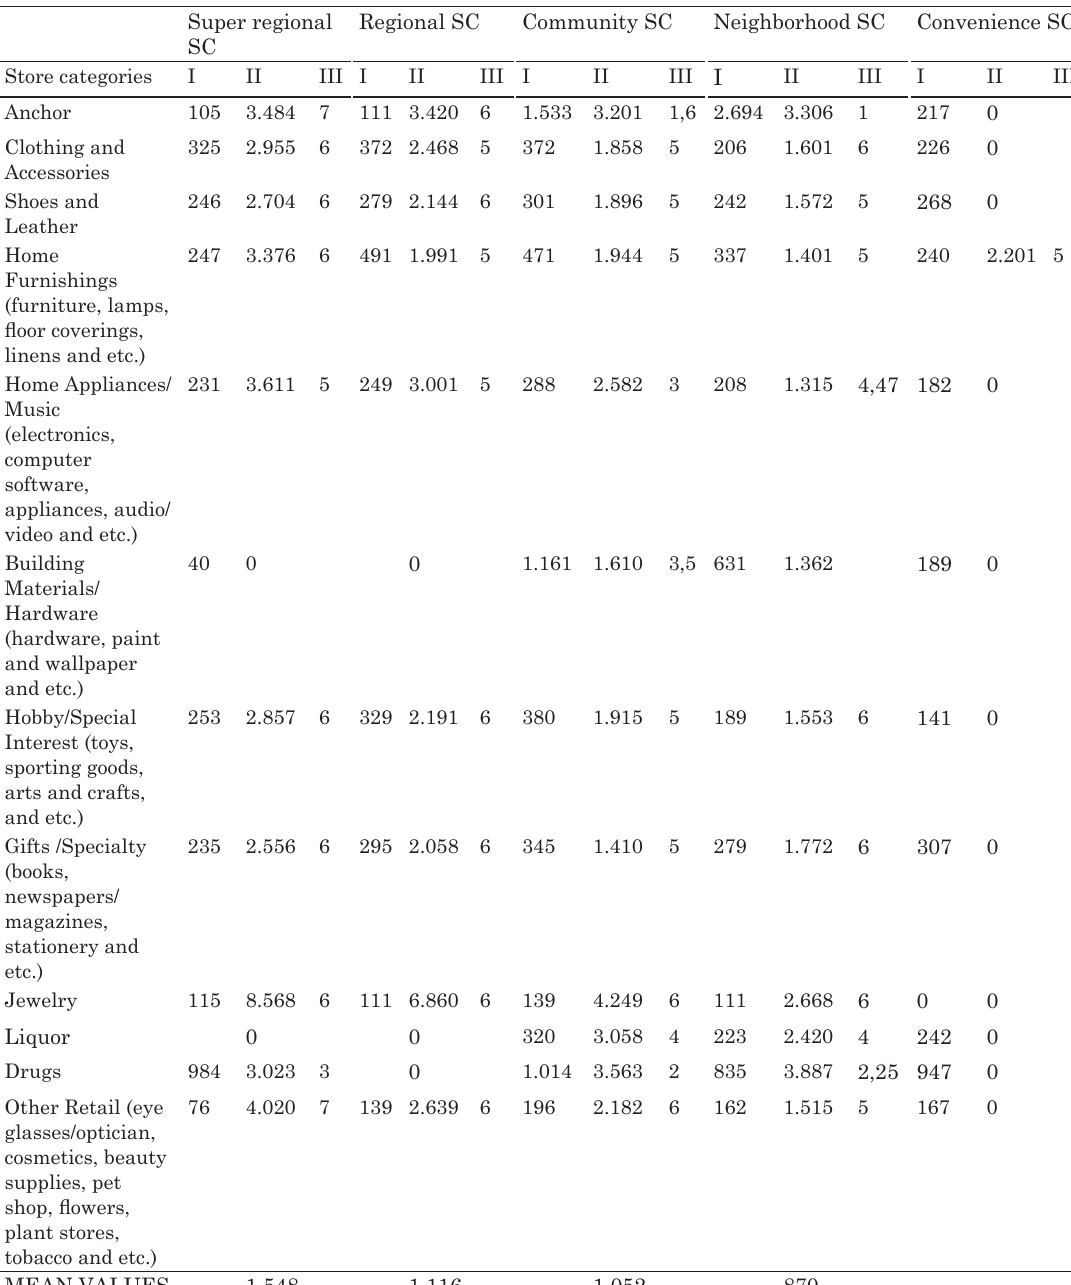
Table 2. Summary data about average lease terms in US presented by ULI (ULI – the Urban Land Institute,